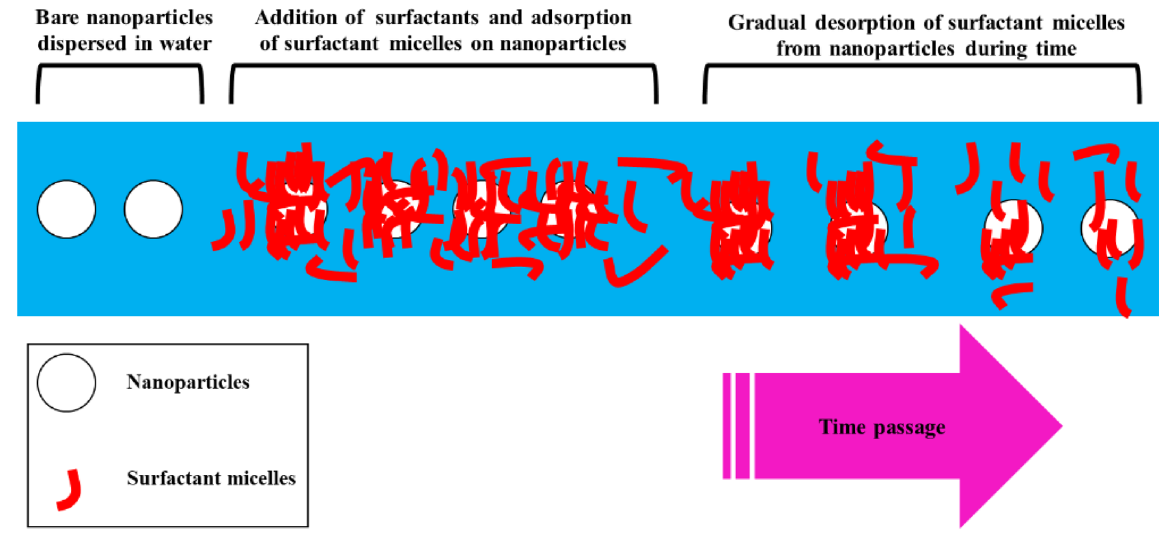
Fig. 5 Schematic description of adsorption/desorption of surfactants by